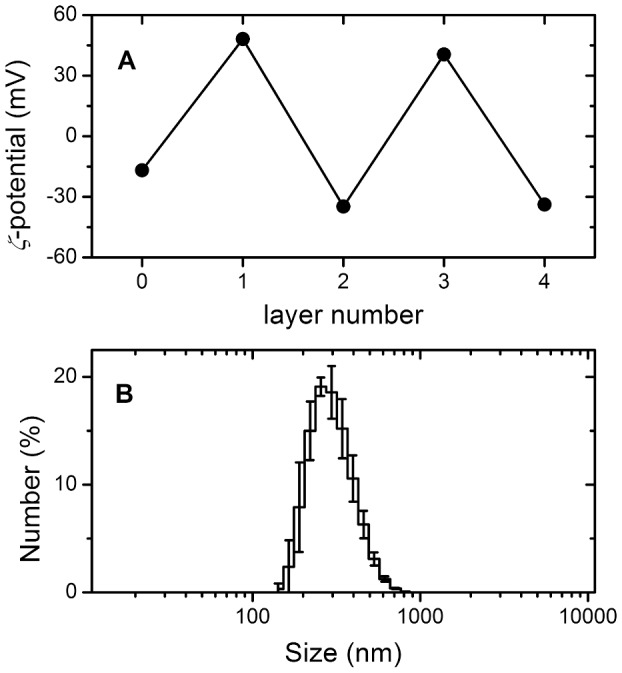
Typical particle size distribution and ζ-potential evolution of nanoparticles.Alternating signs on the ζ -potential confirms PEM build-up (A). The particle size distribution is of particles prior to any coating (B). Those coated show a shifted distribution.